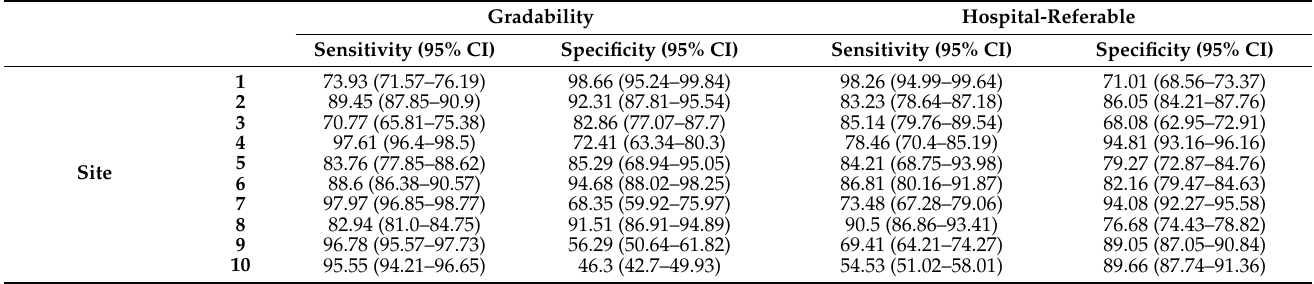
Table 3. VISUHEALTH-AI DR gradability and hospital-referable performance evaluation by site, age category, and visual